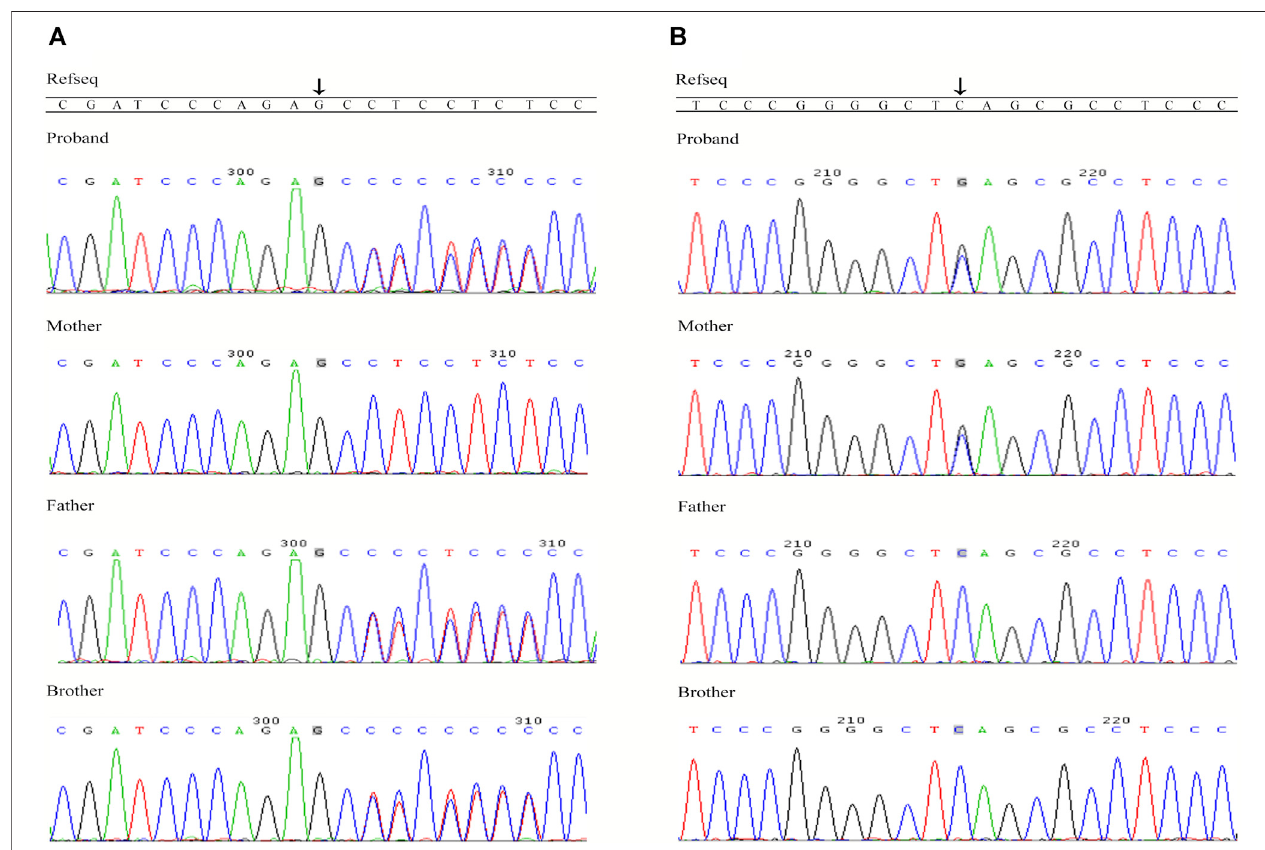
FIGURE 2 | Sanger sequencing con fi rmation of the variants in TRIOBP identi fi ed in this study. (A) Sequences of the heterozygous frameshift variant c.1170delC (p.S391Pfs*488) and the corresponding wild-type sequence; (B) Sequences of the heterozygous Nonsense mutation c.3764C > G (p.S1255*) and the corresponding wild-type